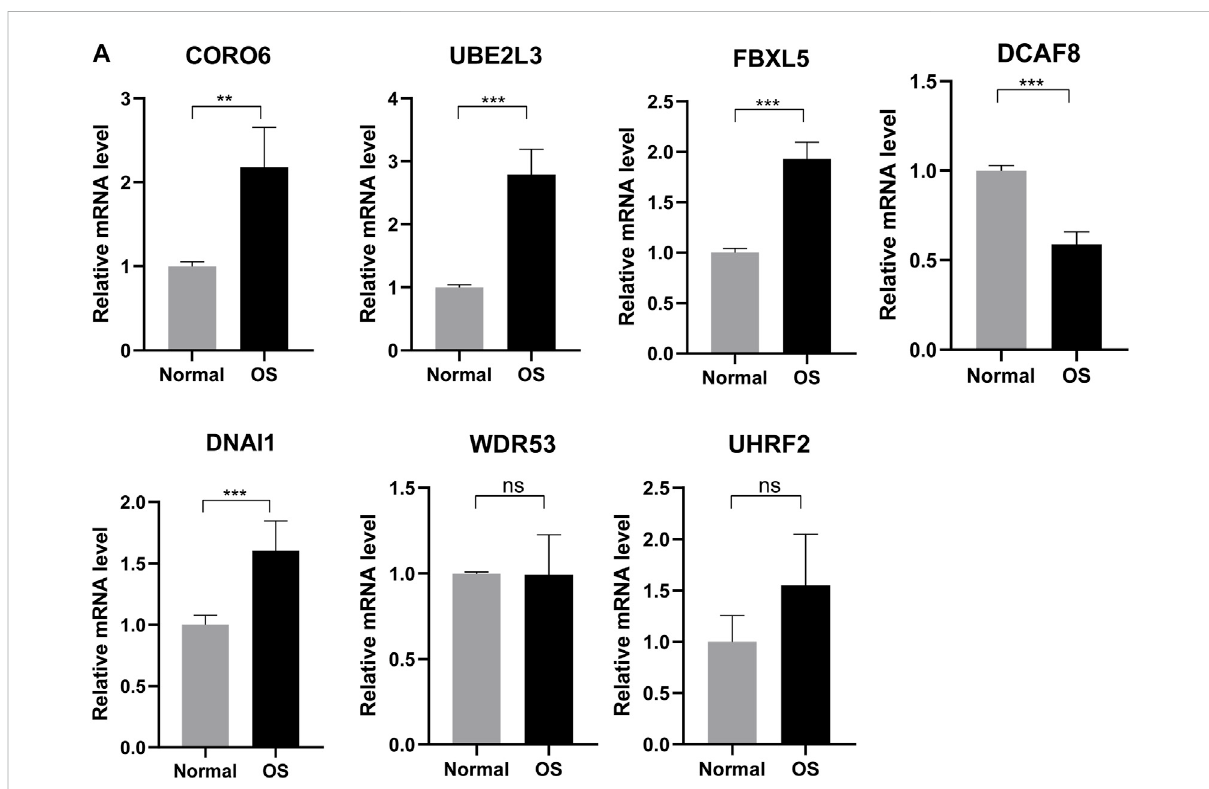
FIGURE 10 Validating expression of the seven genes in normal and osteosarcoma tissues. (A) The mRNA expression level of four ubiquitin-related genes (UBE2L3, CORO6, DCAF8, DNAI1, FBXL5, UHRF2, WDR53) in six normal and six osteosarcoma samples tissues. * p < 0.05, ** p < 0.01 , *** p <